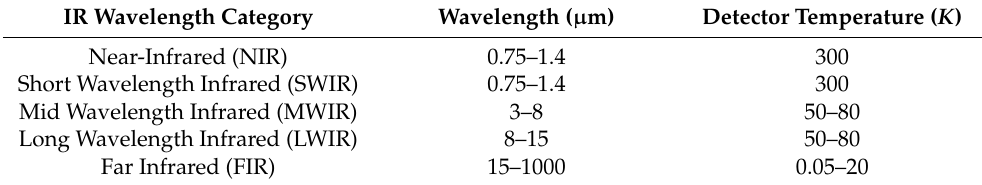
Table 1. Infrared instrument—Detector temperature requirements [16,17].